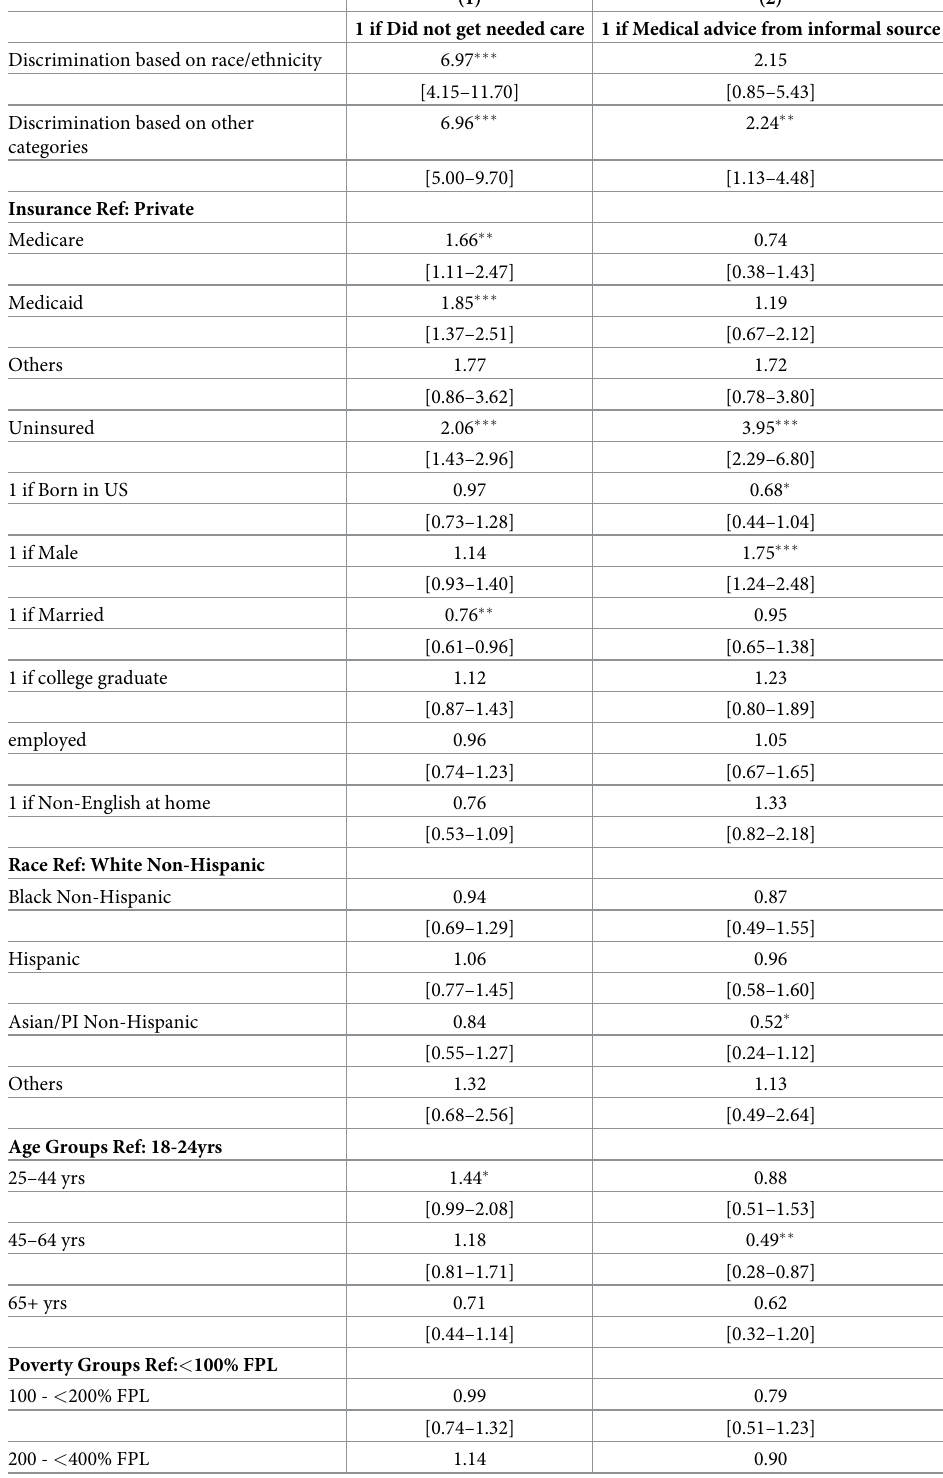
Table 2. Association between health access and types of discrimination: 2016 NYC Community Health